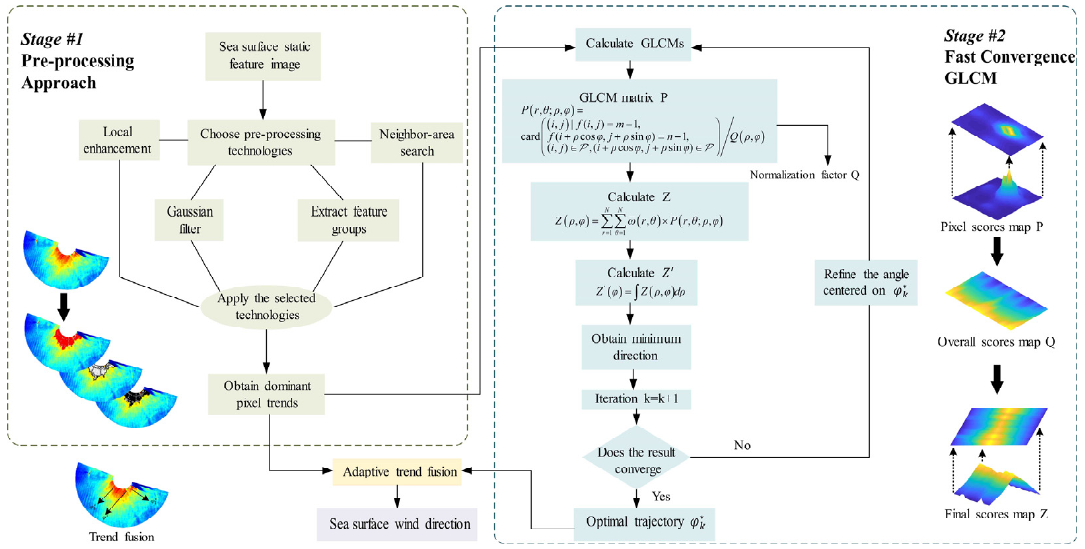
Figure 5. The framework of the proposed FC-GLCM algorithm.